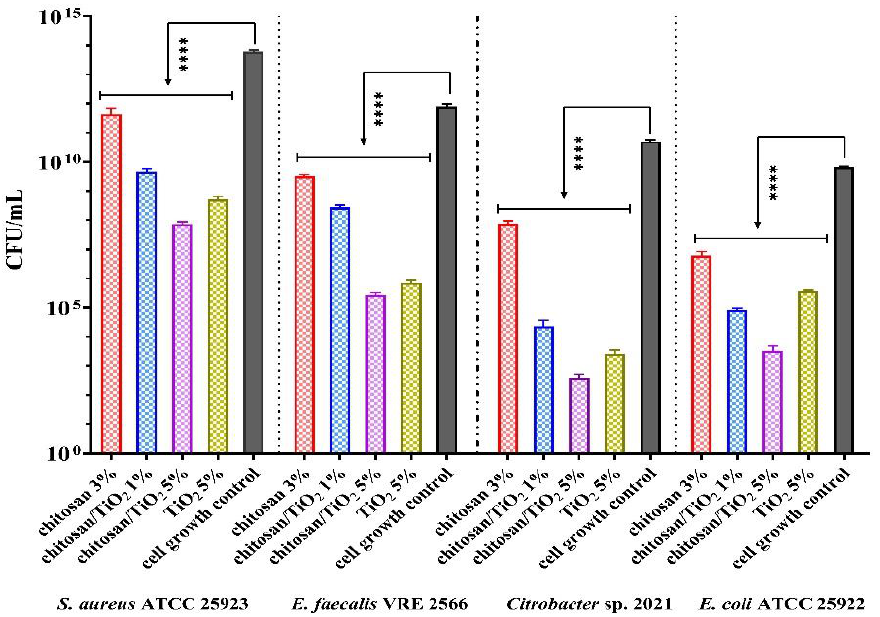
Figure 17. The influence of chitosan-based membranes against Gram-positive and Gram-negative bacteria. The significant differences between groups and cell wall control were statistically analyzed using one-way ANOVA, followed by Dunnett’s multiple comparisons test (**** p < 0.0001). The sensitivity of the bacterial strains can also be explained by the small size of the TiO 2 nanoparticles (~30 nm), which have a higher interaction with the bacterial cells and activate the damage processes [96].